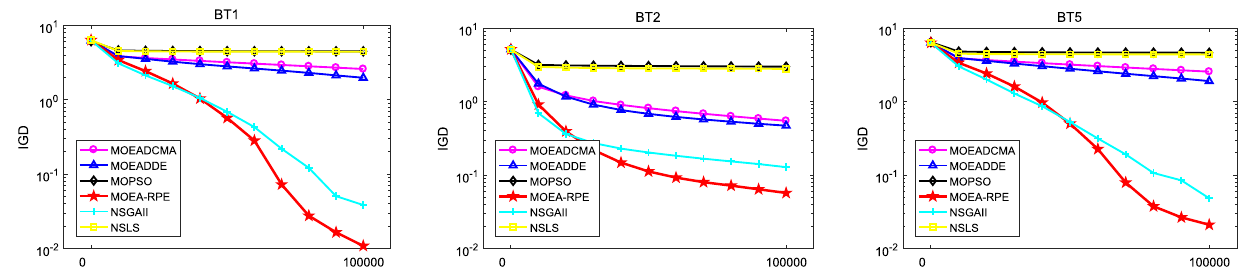
Fig. 5 The IGD curves with respect to the fitness evaluation times on BT1, BT2, and BT5